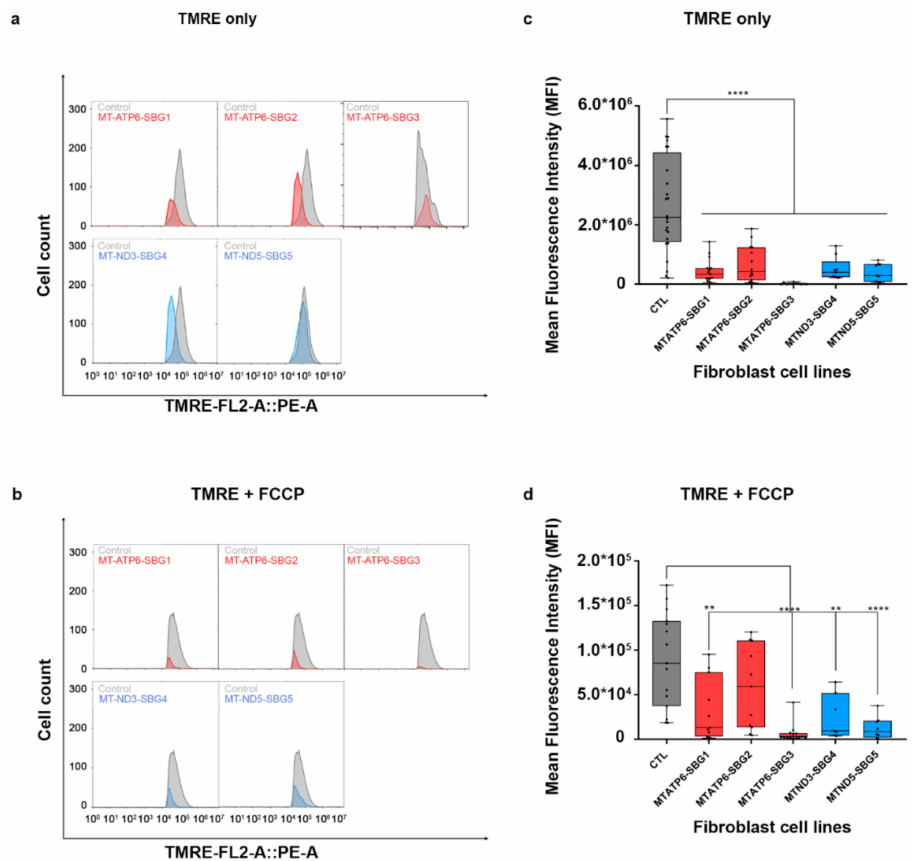
Figure 13. Mitochondrial membrane potential (MMP) analysis of BJ-FB and LS fibroblast cell lines. Using flow cytometry, along with membrane-potential sensitive dye (TMRE), MMP was evaluated. Representative flow cytometry histogram of five fibroblasts (SBG1–5 and Control BJ) ( a ) stained with TMRE only; ( b ) stained with TMRE after treatment with FCCP. Mean fluorescence intensity (MFI) was calculated based on three independent runs, which are shown for (Control BJ-FB in grey; SBG1-FB (MT-ATP6-T8993G), SBG2-FB (MT-ATP6- T8993G), and SBG3-FB (MT-ATP6-T9185C) in red; SBG4-FB (MT-ND3-T10158C) and SBG5-FB (MT-ND5-T12706C) in blue) all samples ( c ) stained with TMRE only; ( d ) stained with TMRE after treatment with FCCP. ** p < 0.01, **** p <